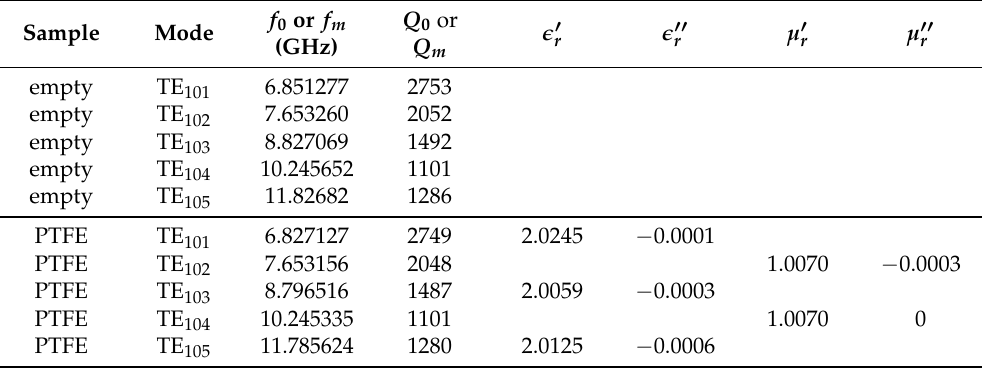
Table 2. Resonant frequency and Q for different modes and samples in the rectangular waveguide resonator and material parameters extracted with Equations (3)–(6).